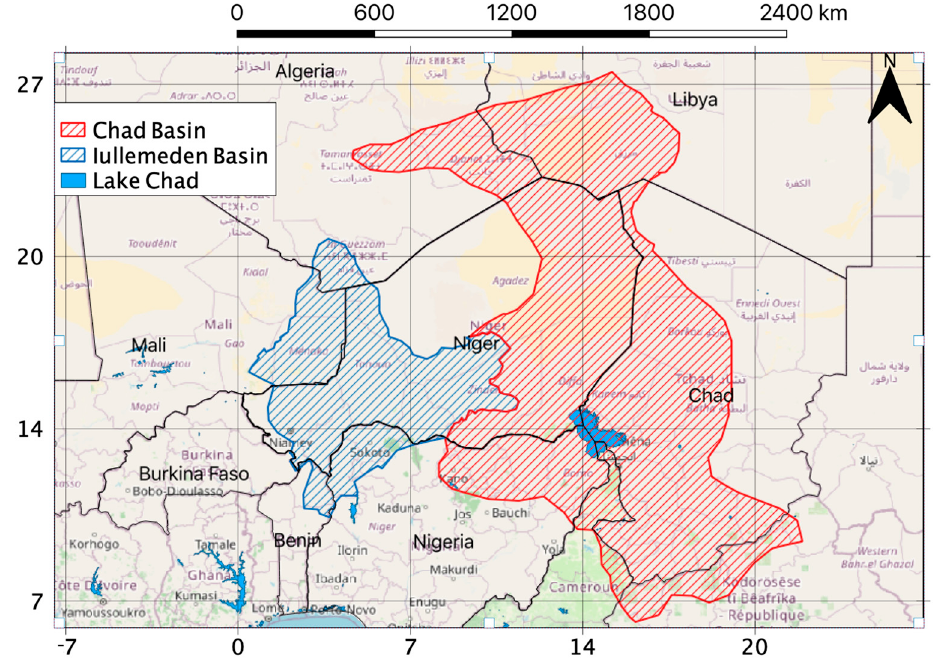
Figure 1. The Iullemeden and Lake Chad basins.